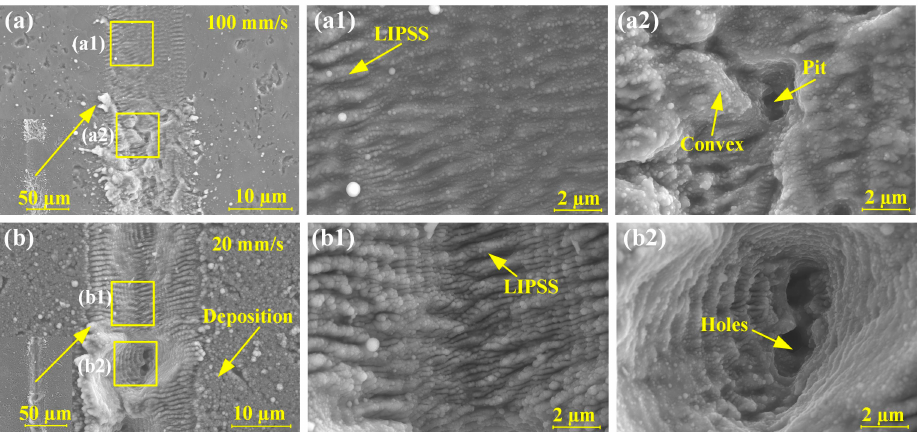
Figure 8. Microgroove morphology for di ff erent scanning speeds at a laser energy of 20 µJ: ( a ) 100 mm/s; ( a 1) Enlarged view of SiC grain region in Figure 8a; ( a 2) Enlarged view of Si matrix region in Figure 8a; ( b ) 20 mm/s; ( b 1) Enlarged view of SiC grain region in Figure 8b; ( b 2) Enlarged view of Si matrix region in Figure 8b.